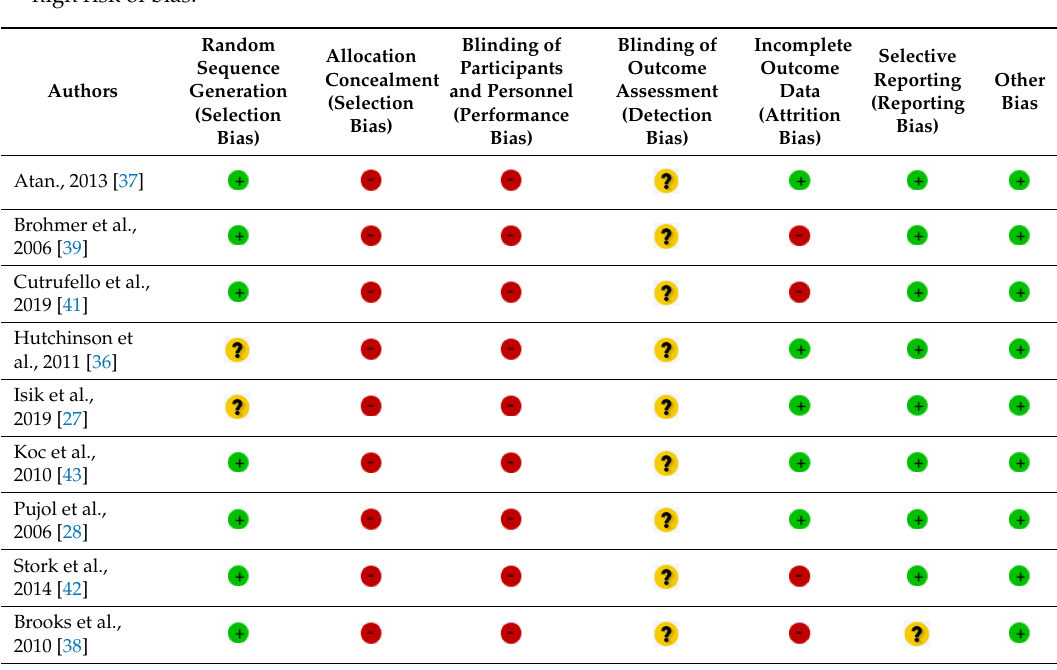
Table 1. Summary showing risk of bias: all studies included are subject to review of authors’ opinions about each risk of bias item. high risk of bias.